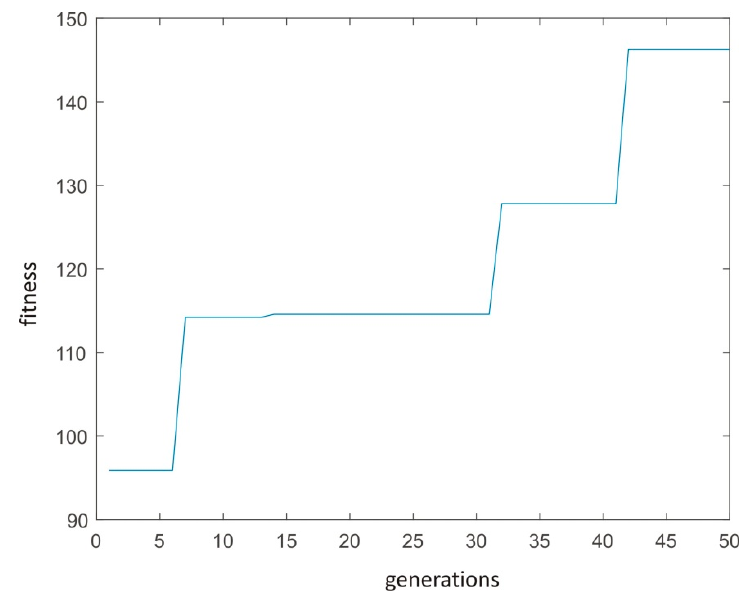
Figure 5. Evolution of the CRO-SL fitness (Equation (2)) in two frequency bands antenna optimization process.